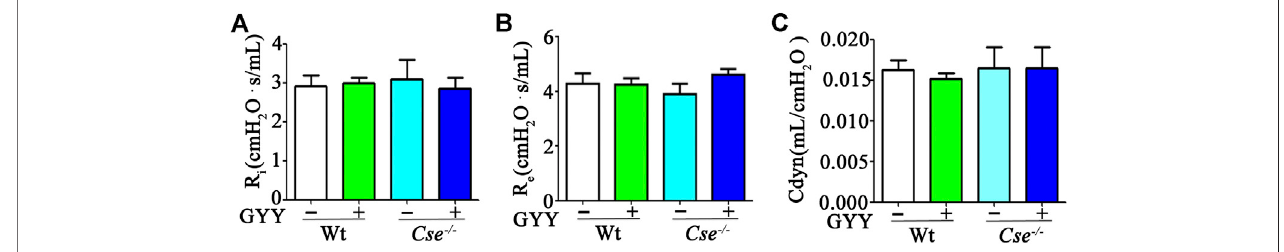
FIGURE 2 | H 2 S de fi ciency does not affect lung airway resistance. WT and Cse -/- mice were administered with saline or GYY4137 (50mg/kg). Twenty-four hours later, the mice were anesthetized and then lung inspiratory resistance (R i ) (A) , expiratory resistance (R e ) (B) , and dynamic compliance (Cdyn) (C) were analyzed byusing AniRes2005 lung function analysis system. The data were expressed as Mean ± SEM; n (cid:2) 8 – 11 per group.